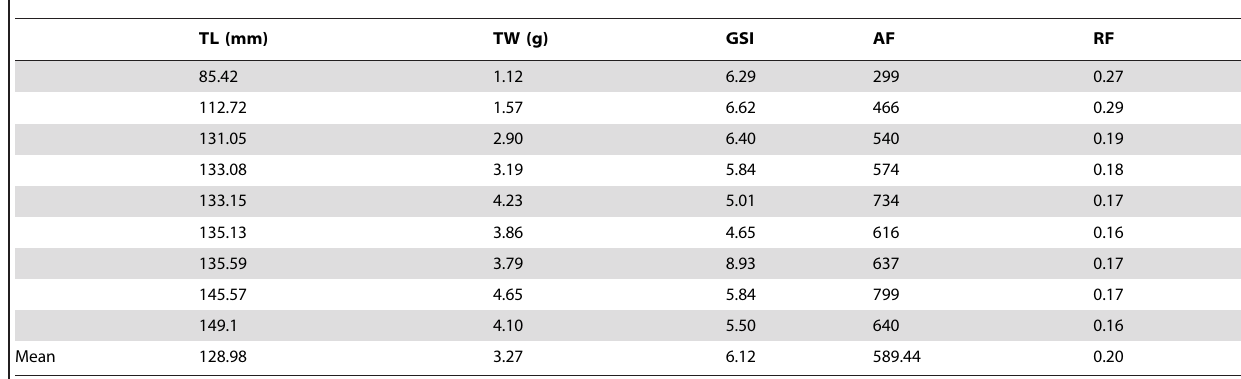
Table 2. Fecundity data.